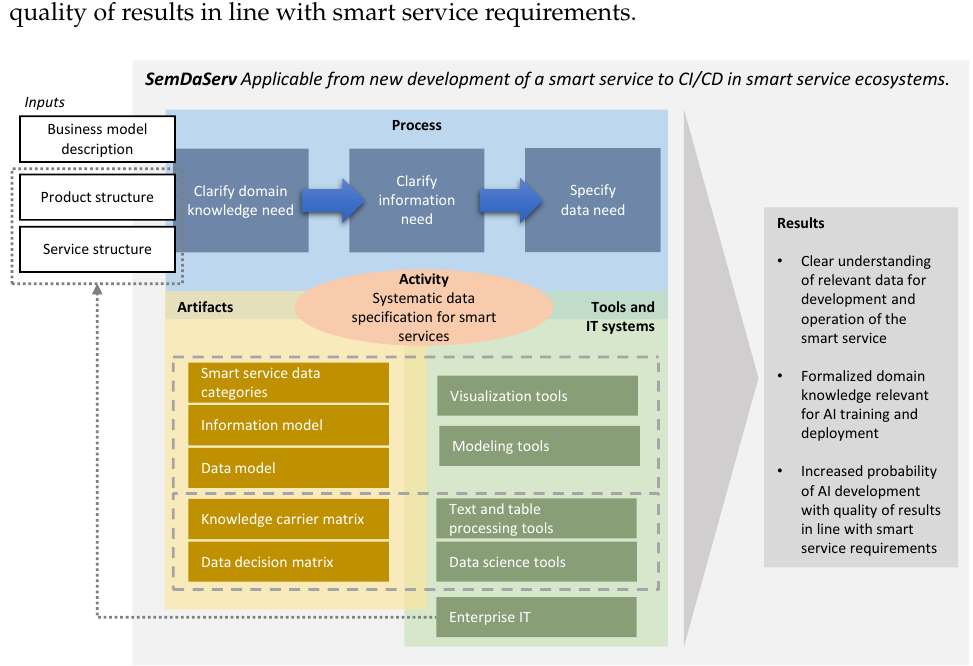
Figure 4. Overview of the SemDaServ